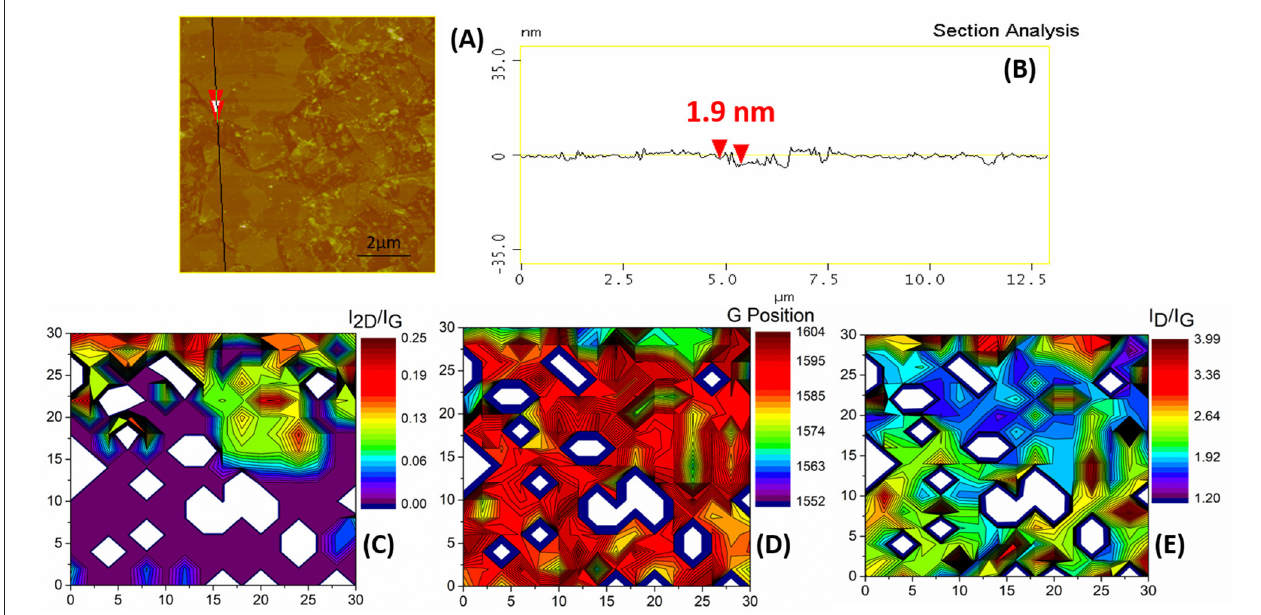
FIGURE 6 | r-GO flakes onto the Si substrate. (A) A high magnification AFM image. The black line and the red arrows indicate the section and point of measurement, respectively for (B) , which is a section analysis with an indicative height measurement. (C) Raman 2D contour plot of the I 2D /I G . (D) Raman 2D contour plot of the G position. (E) Raman 2D contour plot of the I D /I G ratio. Axis dimensions in all Raman plots are in µ